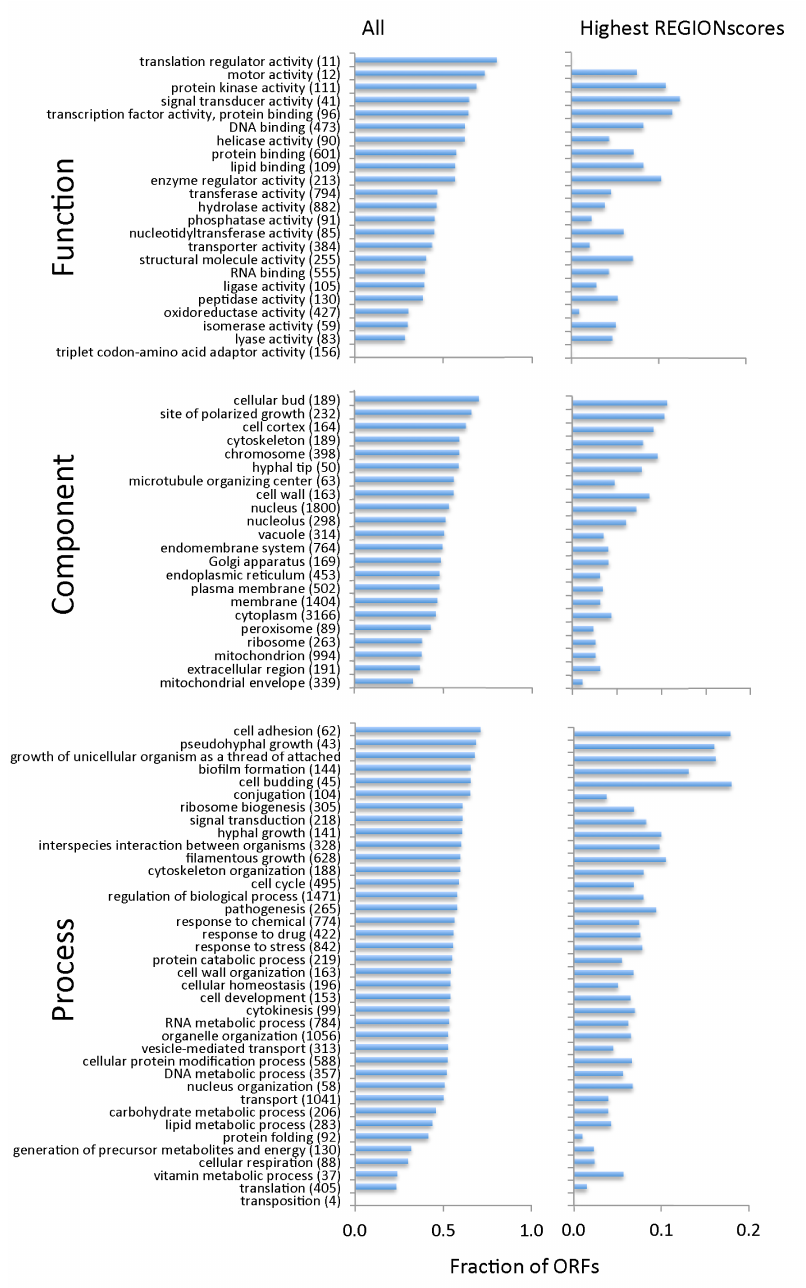
Figure 2. Frequency of TR-ORFs in different gene categories. Shown are the fractions of all genes in the C. albicans genome mapped to GO slim terms that are TR-ORFs. Numbers in brackets next to a term are the total number of genes in the genome mapped to that term. Shown on the left (All) are fractions of genes containing TR-ORFs. Fractions on the right (Highest REGIONscores) show the fraction, in each gene category, of TR-ORFS containing pcTRs whose REGIONscores are in the top 10% of all